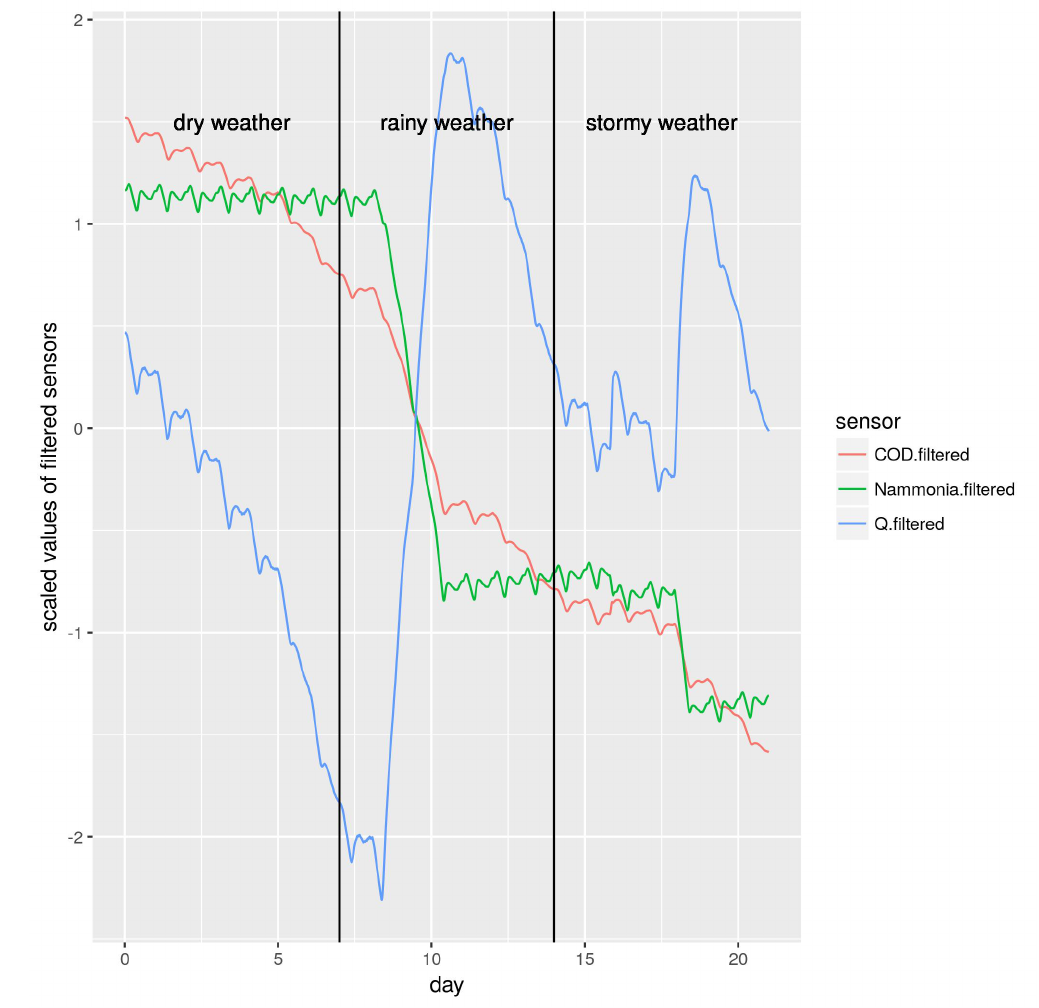
Figure 4. Relationship among Q, COD and N-ammonia measures after bring scaled and strongly